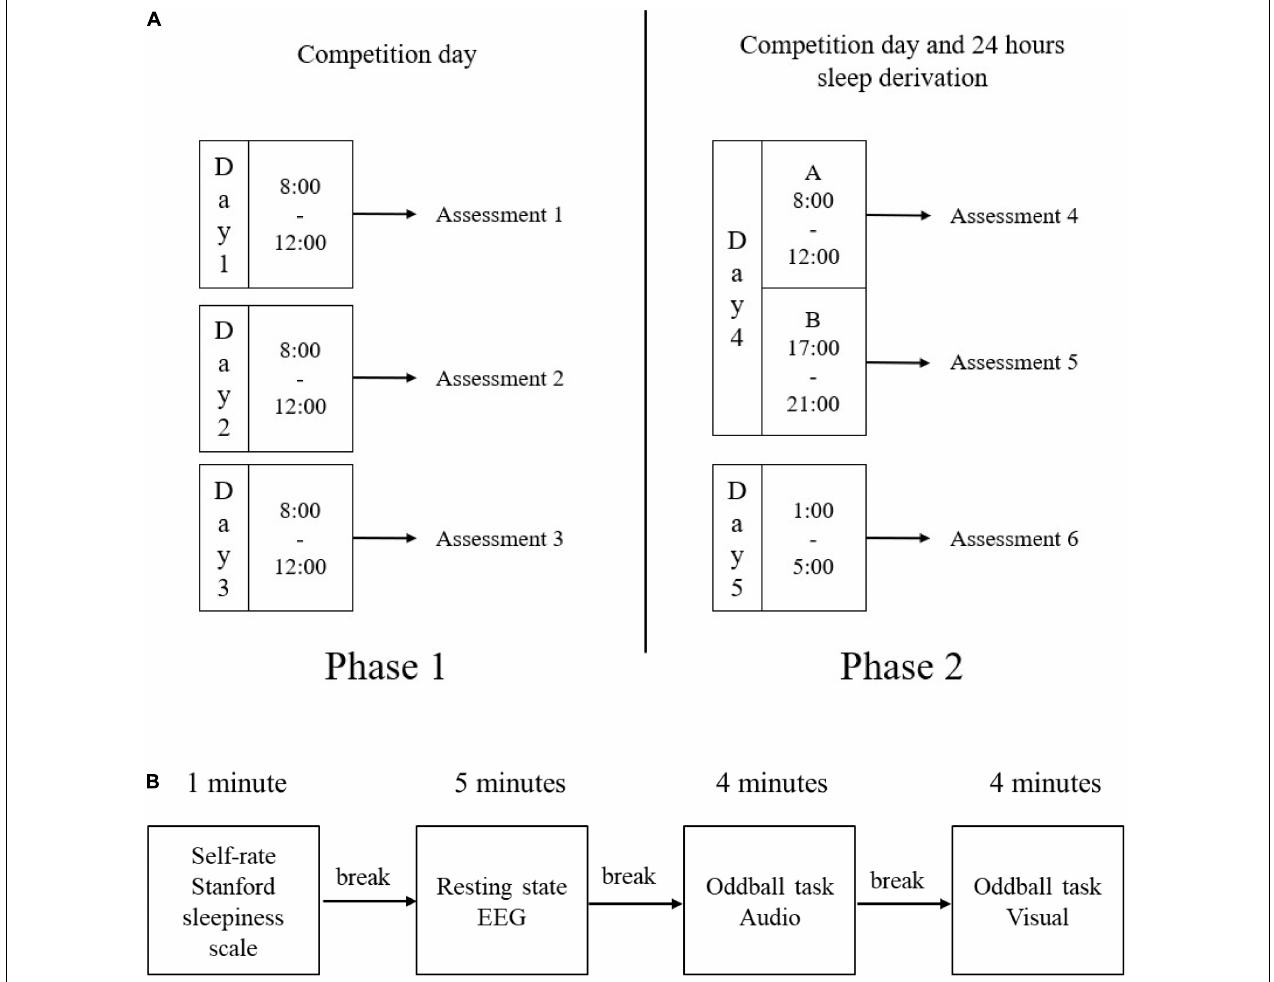
FIGURE 1 | Experimental procedures. (A) The experiment included two phases, i.e., phase 1 with each assessment session for the first three consecutive competition days, and phase 2 with three assessment sessions with a 24-h period of sleep deprivation during the last two competition days. (B) The assessment included four sessions, which were 1 min self-rating, 5 min resting-state EEG, 4 min audio stimulation oddball task, and 4 min visual simulation oddball task; there were short breaks between each session. EEG = electroencephalography.